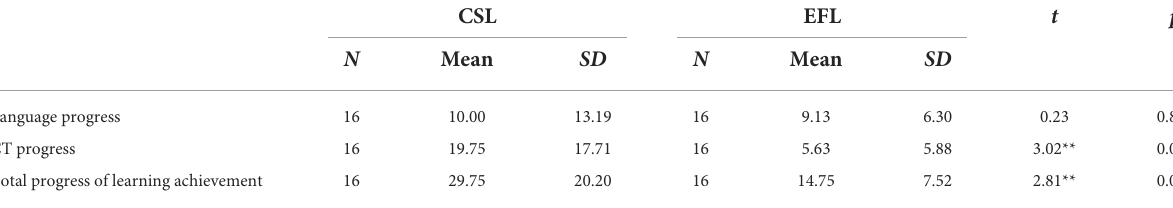
TABLE 2 Progress scores of the independent sample t -test results between the two